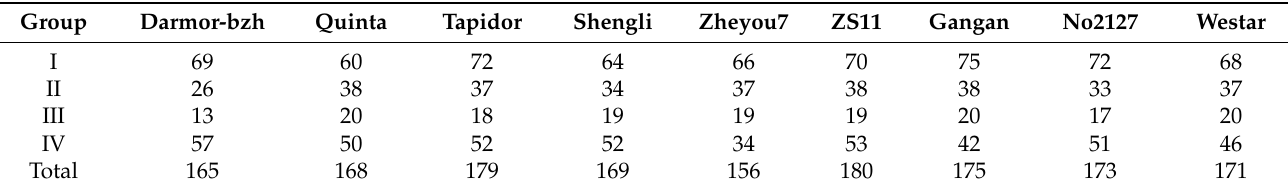
Table 1. Count of BnHD-Zip genes per